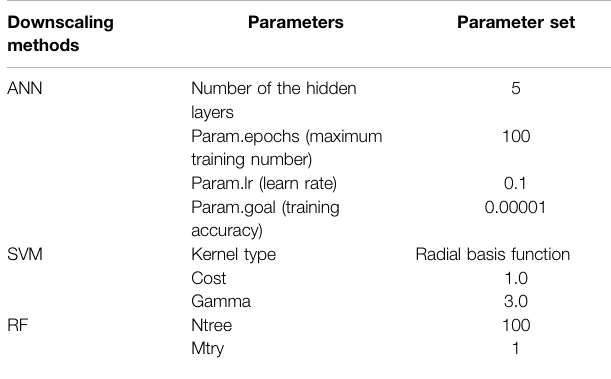
TABLE 2 | Parameter settings for three machine learning-based downscaling